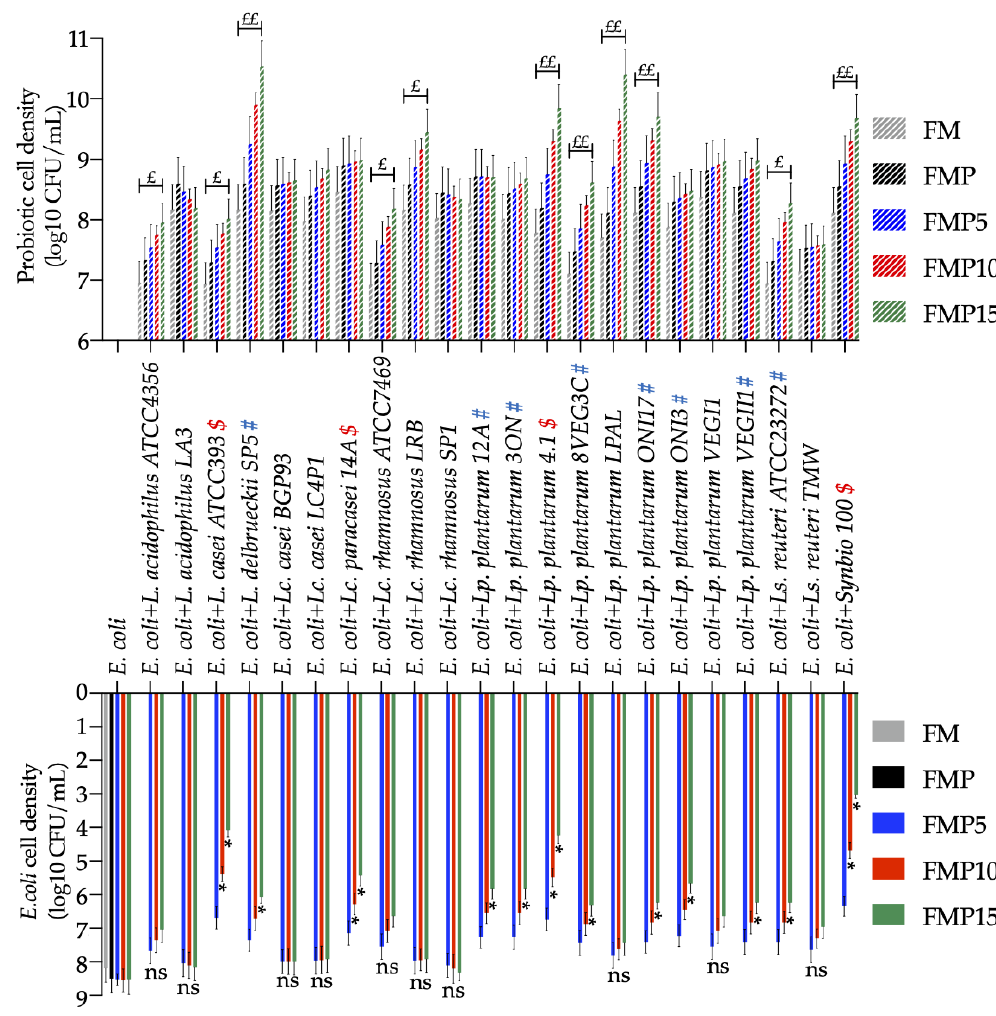
Figure 5. In vitro prebiotic assay showing the cell density of 22 probiotic lactic acid bacteria co- cultured with E. coli in fecal batches not containing carbohydrates (FM) or made with the addition of pasta without inulin (FMPC) and inulin-enriched pasta at 5 (FMP5), 10 (FMP10), and 15% (FMP15). “£” means >0.5 log10 cycle increased cell density (CFU/mL) of probiotic lactic acid bacte-ria in FMP15 versus FMP; “££” means >1 log10 cycle increased cell density (CFU/mL) of probiotic lactic acid bacteria in FMP15 versus FMP. “#” and “$” indicate those probiotics that had respective-ly determined a significant decrease of E. coli cell density in FMP15 or both FMP15 and FMP10. “*”: significant decrease of E. coli cell density compared to FMP; “ns”: no significant differences.